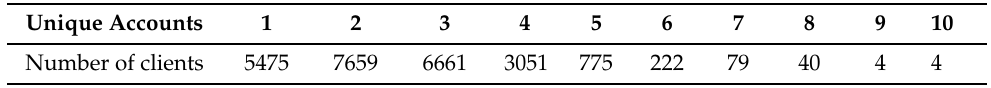
Table 3. The number of clients by number of accounts.